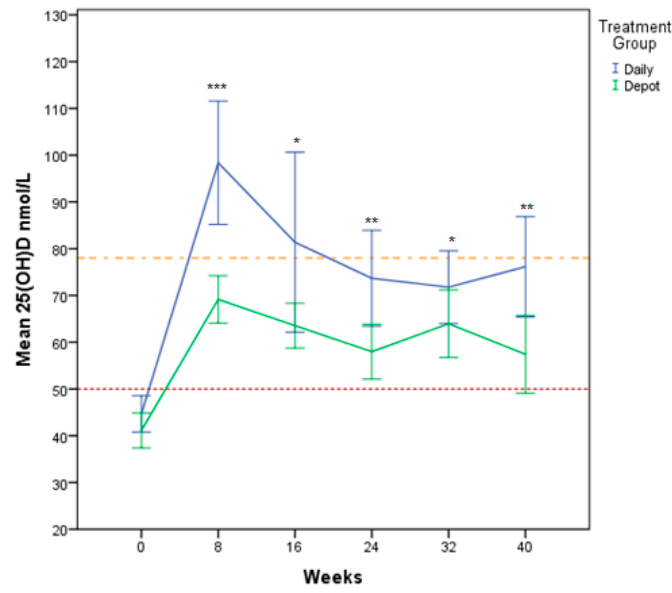
Figure 3. Mean 25(OH)D (nmol/L) change over time for Daily and Depot Treatment Groups. Raw mean 25(OH)D nmol/L change over time. -- represents threshold level 50 nmol/L -- represents threshold level 78 nmol/L * p < 0.05; ** p < 0.01; *** p < 0.001. Table 2. Biochemical and sun exposure data. Table 3. Frequency (percent) of participants according to 25(OH)D level cut-off Vitamin D 3 Treatment Daily Vs.